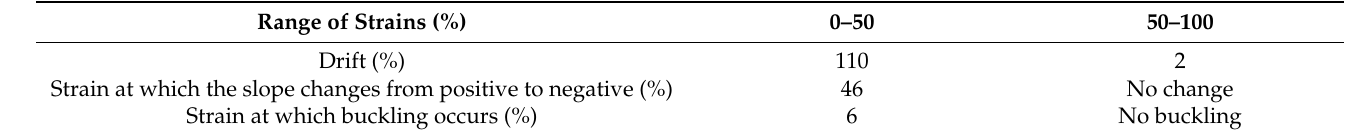
Table 2. Characteristics of the ShSF performance derived from the dynamic tensile testing of the ShSF. Range of Strains (%) 0–50 50–100 Drift (%) 110 2 Strain at which the slope changes from positive to negative (%) 46 No change Strain at which buckling occurs (%) 6 No buckling